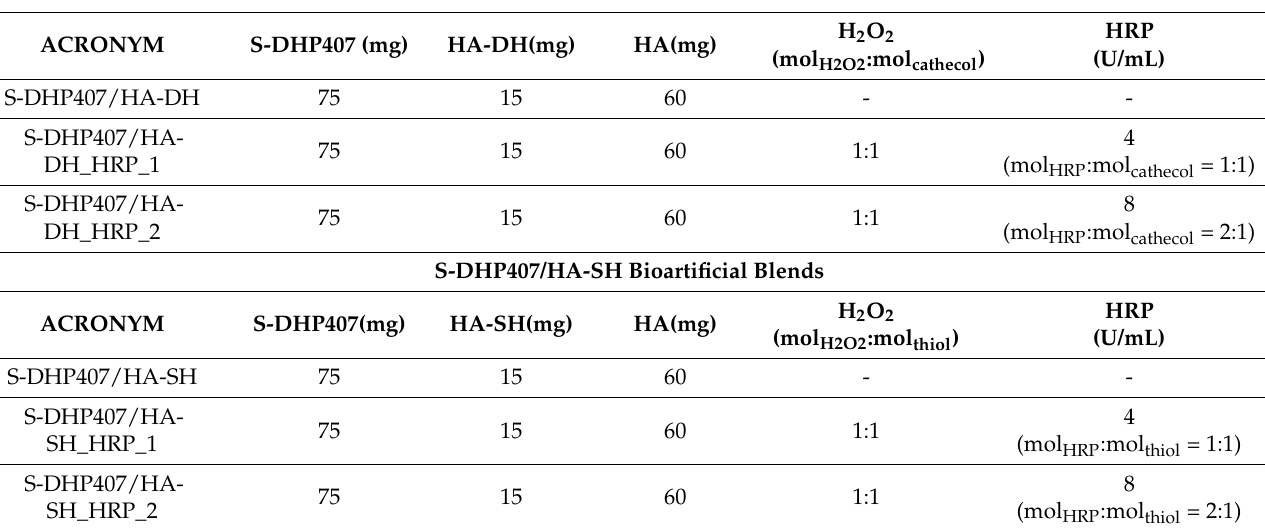
Table 2. Nomenclature of the developed bioartificial blends based on S-DHP407 and HA-DH_pH5 (referred to as HA-DH) or HA-SH_pH5 (identified with the acronym HA-SH). Amounts of each component required for the preparation of 1 mL of bioartificial formulation. H 2 O 2 was added to some formulations at 1:1 molar ratio with respect to HA thiol/catechol groups, while for HRP two different molar ratios with respect to HA functional groups (i.e., thiol or catechol groups) were tested (i.e., 1:1 and